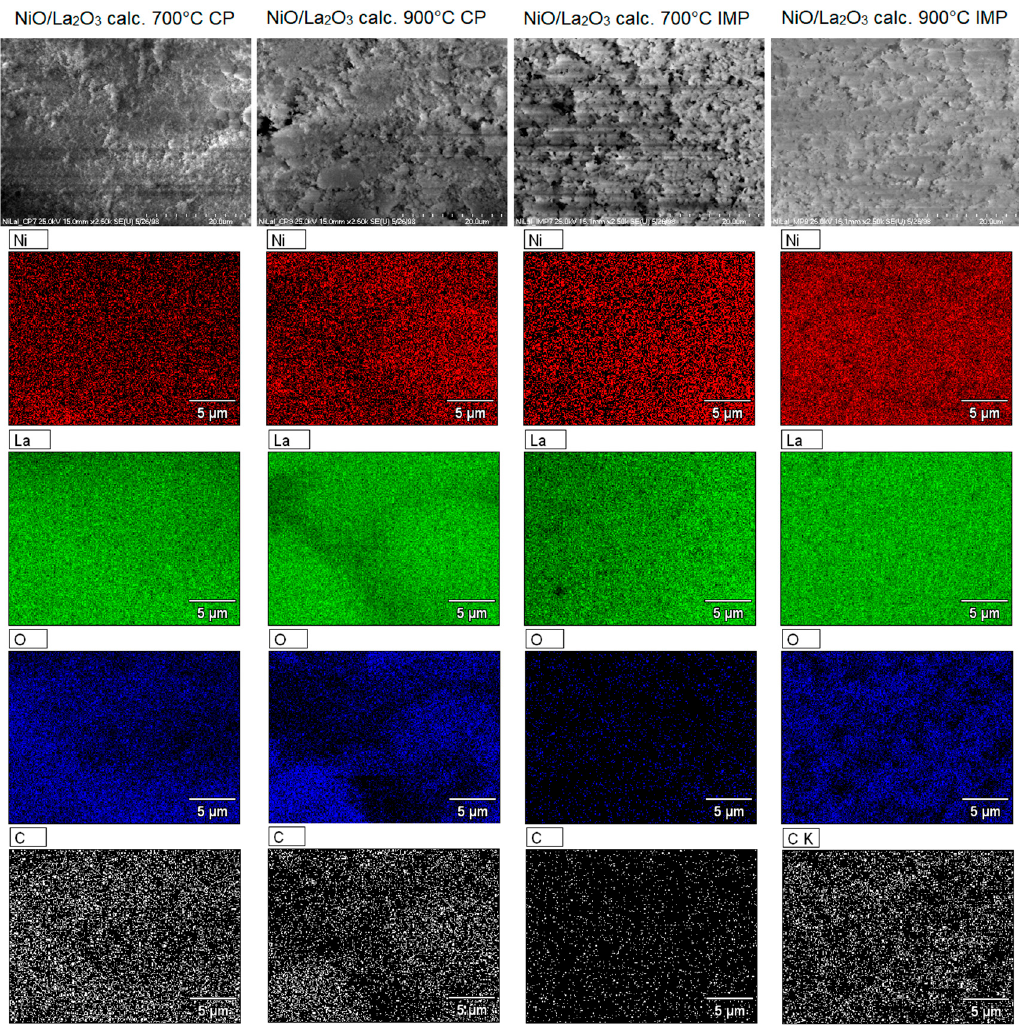
Figure 7. SEM images of investigated catalysts being after OSR-LNG reaction.